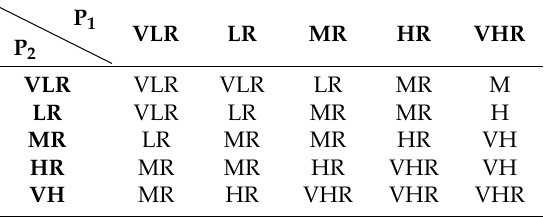
Table 3. Example cases for illustration of rules specification using A RB and M RB schemes.